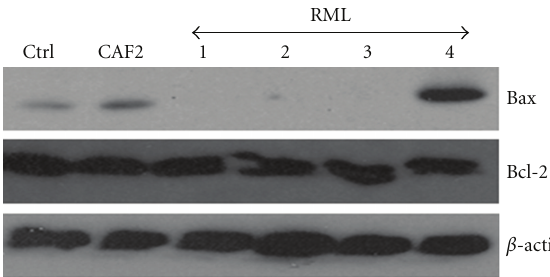
Figure 6: Bax and Bcl2 protein analyses following EHOM infection with C. albicans strains. Total proteins were extracted from the infected EHOMs and analyzed by western blotting for Bax and Bcl2 production. Gels are representative ( n = 5).